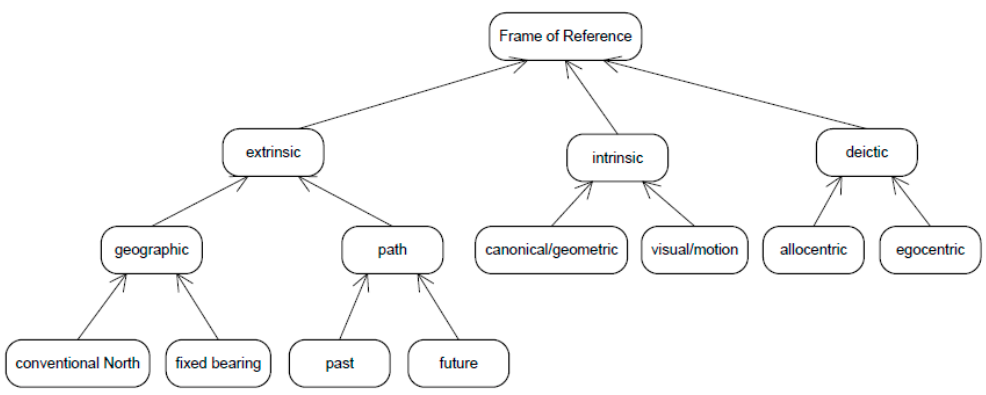
Figure 3. Taxonomy of frames of reference (figure taken from [21]).